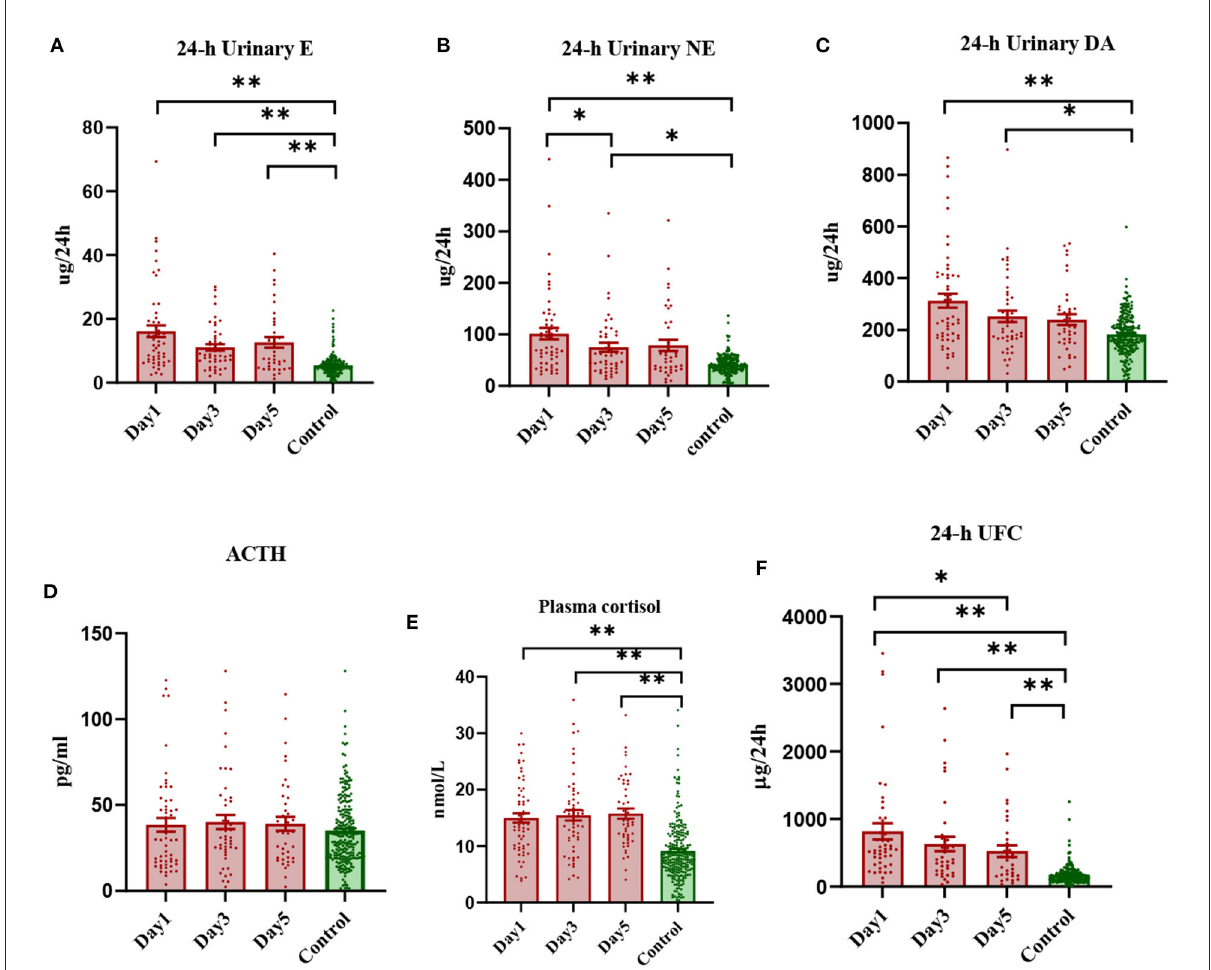
FIGURE1 Scatterplot of early levels of each hormone in stroke patients vs. healthy controls (median and interquartile range). * Denotes P < 0.05, ** denotes P < 0.01.